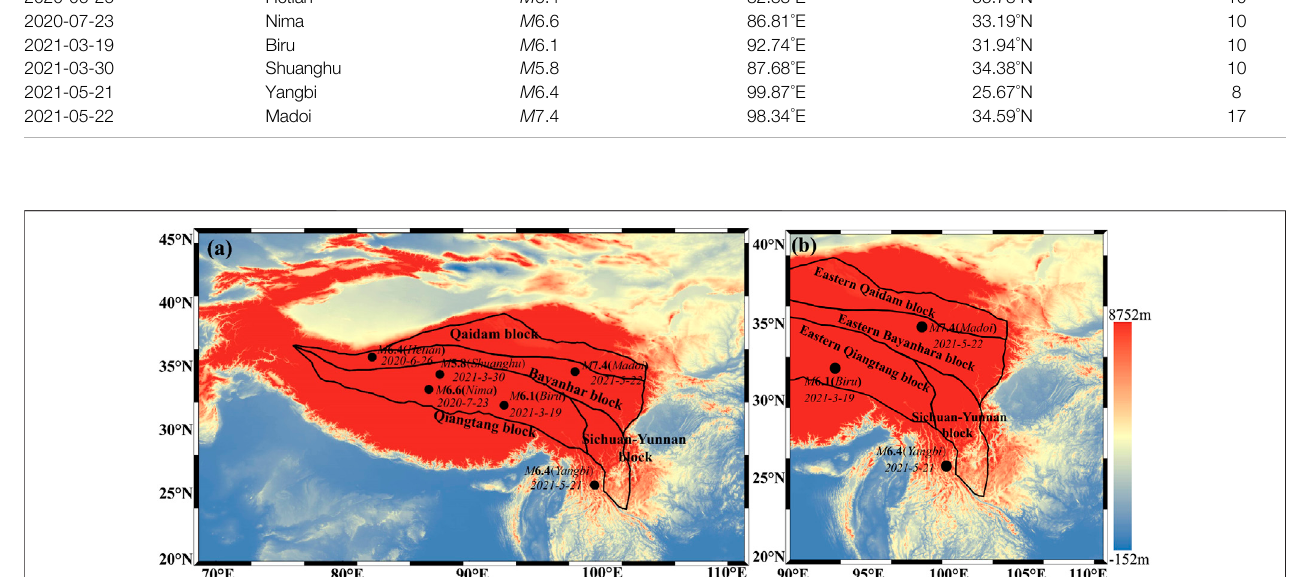
FIGURE 1 | Distribution of earthquakes (active from 2020.06 to 2021.05) with M ≥ 5.8 in (A) the Qinghai-Tibetan Plateau and (B) its eastern margin.